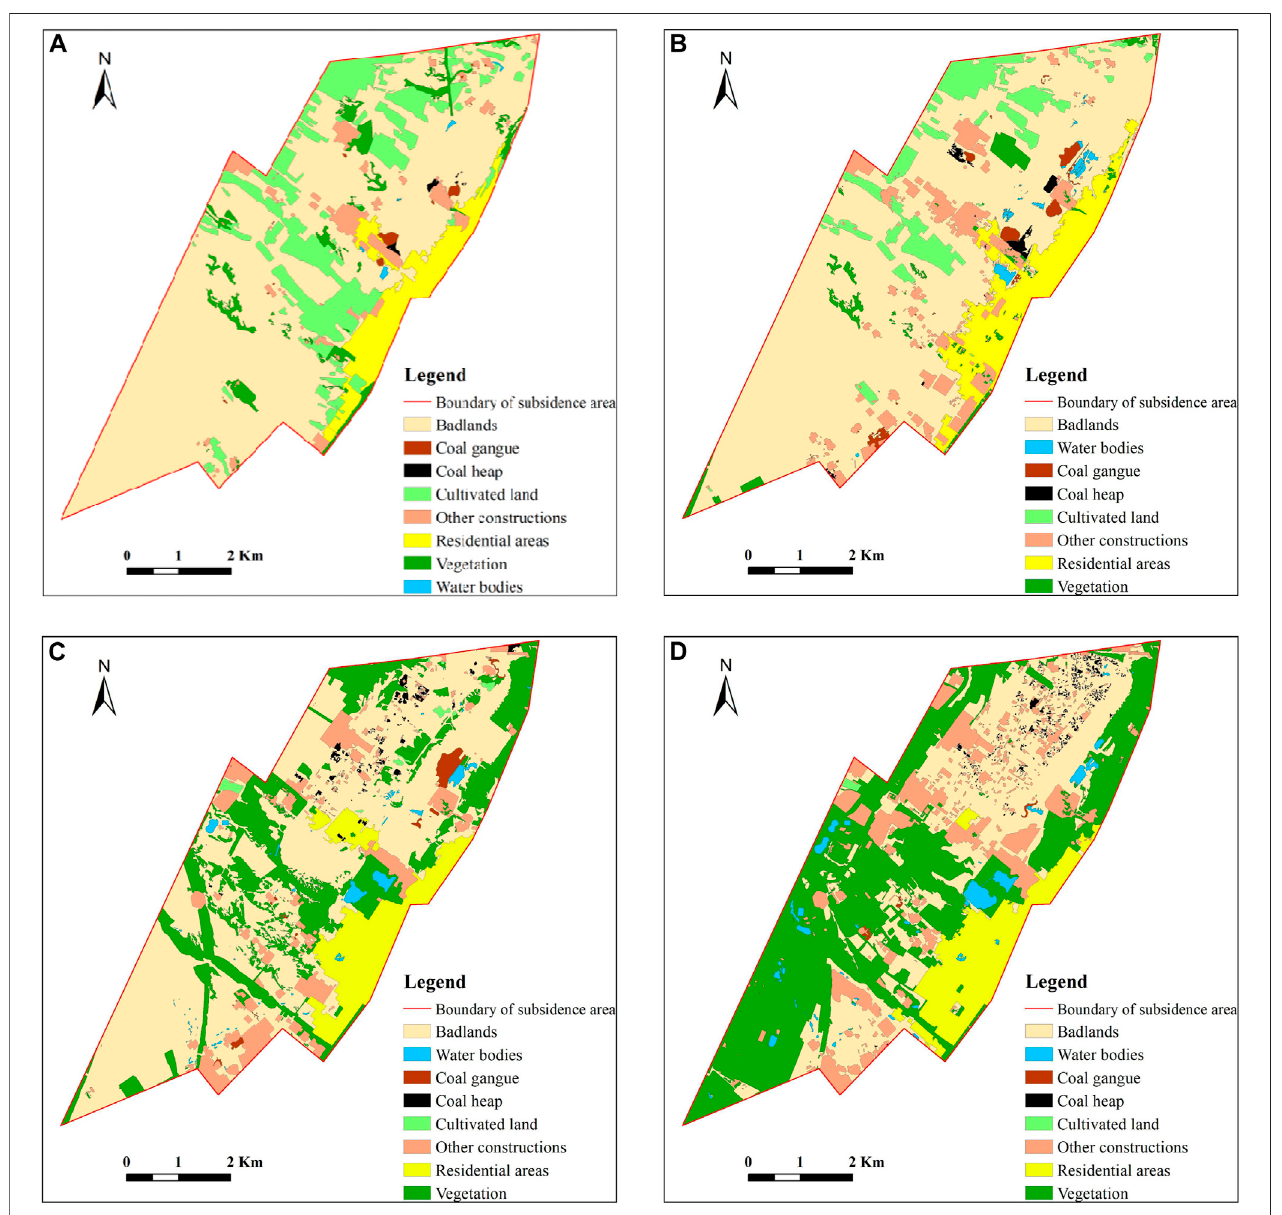
FIGURE 10 | Interpretation map of surface environmental elements in coal mining subsidence area. (A) 1979, (B) 2003, (C) 2011, and (D) 2018.